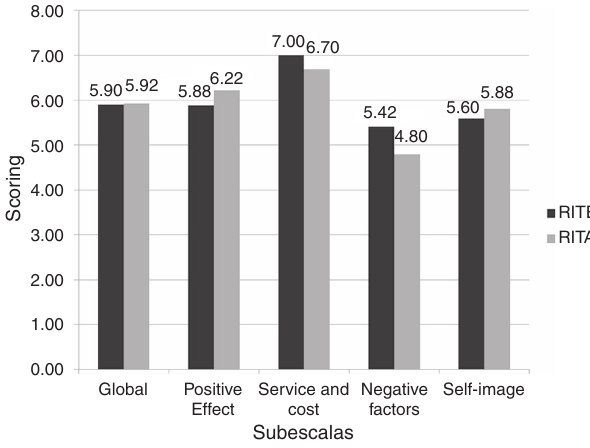
Mean score of satisfaction level of receiver in the ear (RITE) and receiver in the aid (RITA) hearing aid users in the four subscales of the Satisfaction with Amplification in Daily Life (SADL) questionnaire ( n =